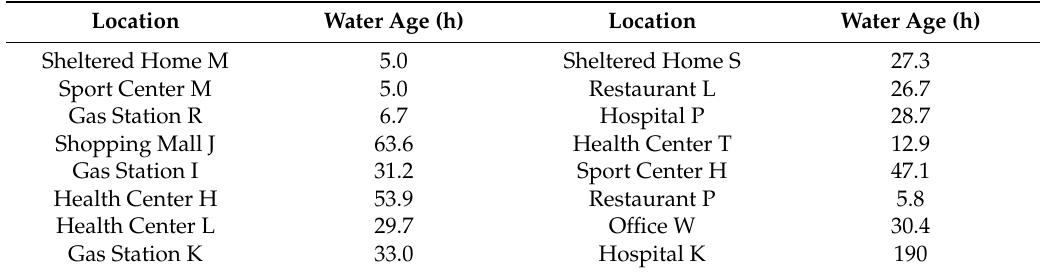
Table 2. The modeled maximum water ages in the sampling locations